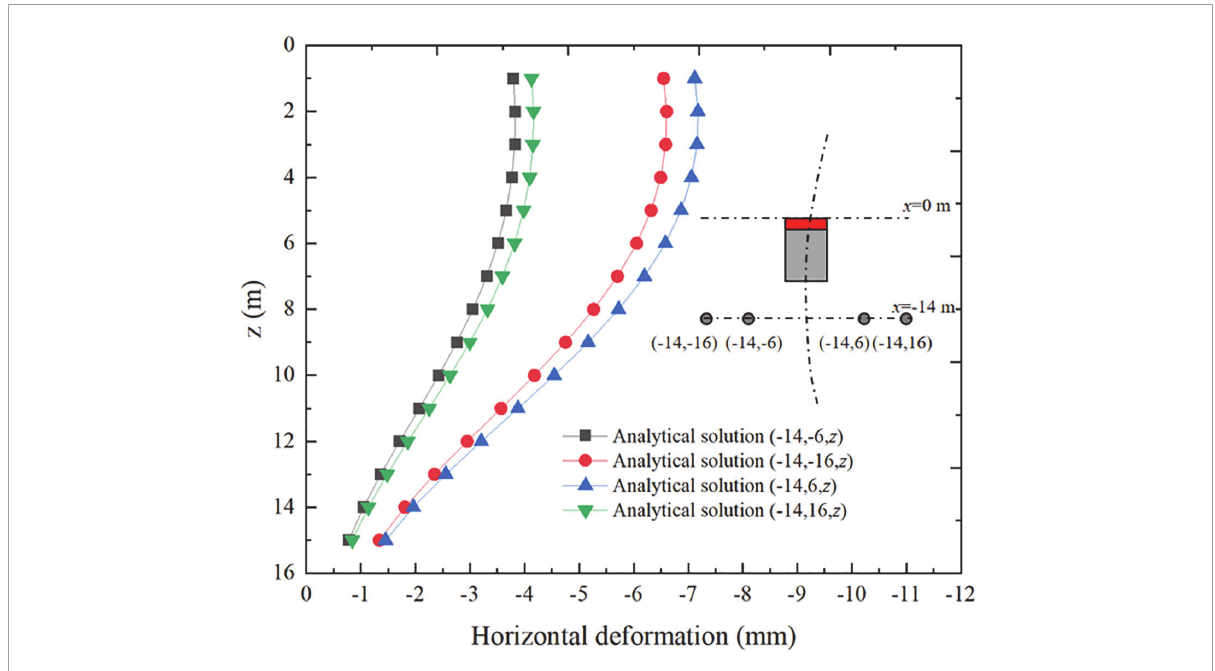
FIGURE12 Horizontal deformation curve of pile